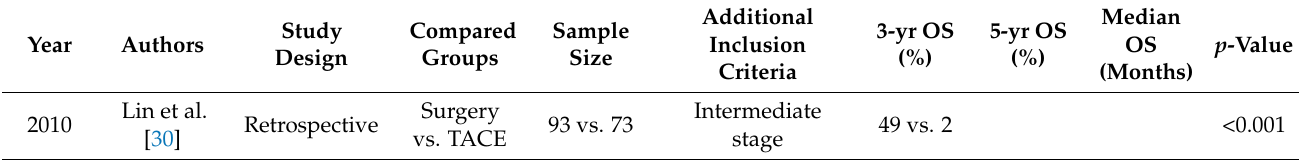
Table 1. Studies comparing Surgery and TACE in BCLC-B patients. OS: overall survival; TACE: trans-arterial chemoembolization; HCC: hepatocellular carcinoma; BCLC: Barcelona clinic liver